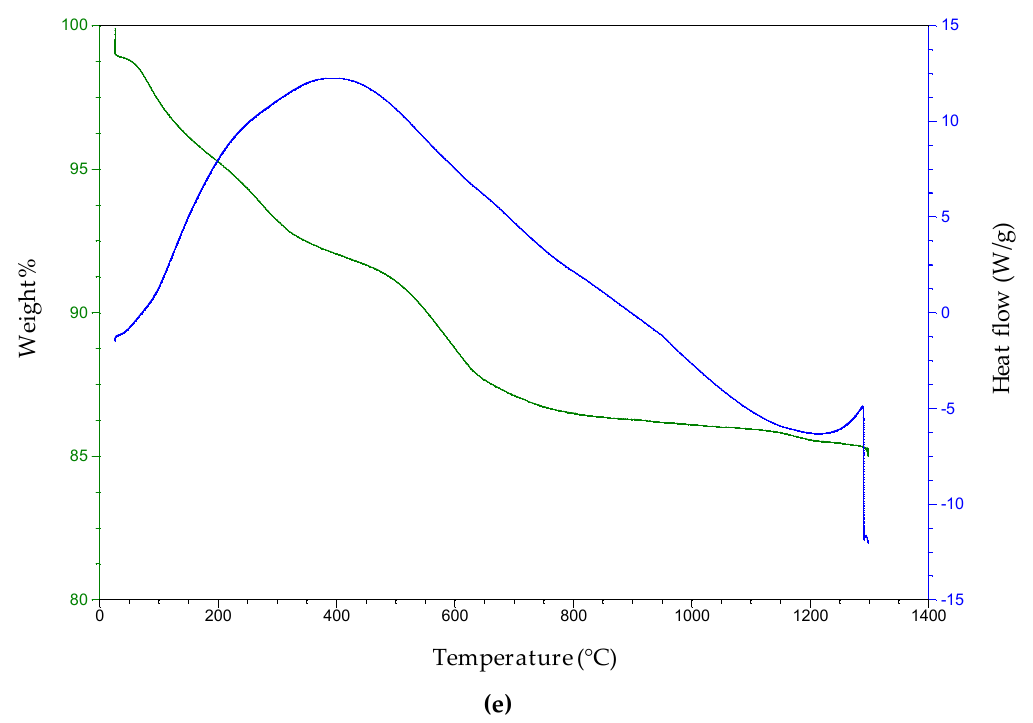
Figure 5. TGA of calcined ( a ) Ni adsorbent; ( b ) Zn adsorbent ( c ) Ni and Zn adsorbent, ( d ) Zr adsorbent ( e ) Zr and Ni adsorbent.